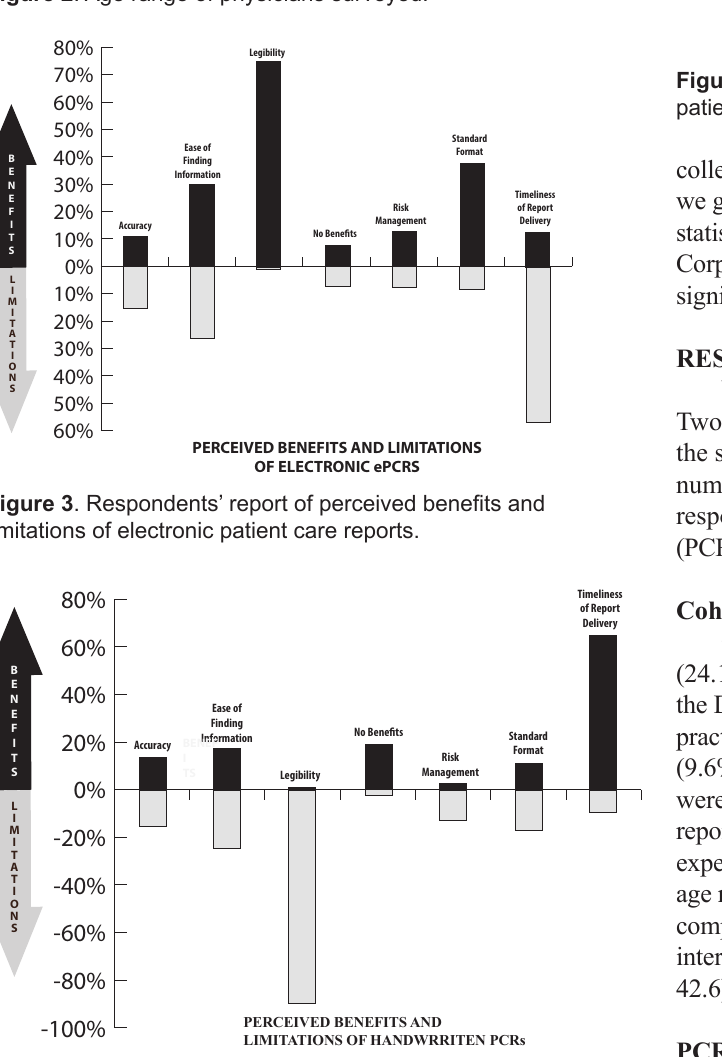
Figure 2 . Age range of physicians surveyed.